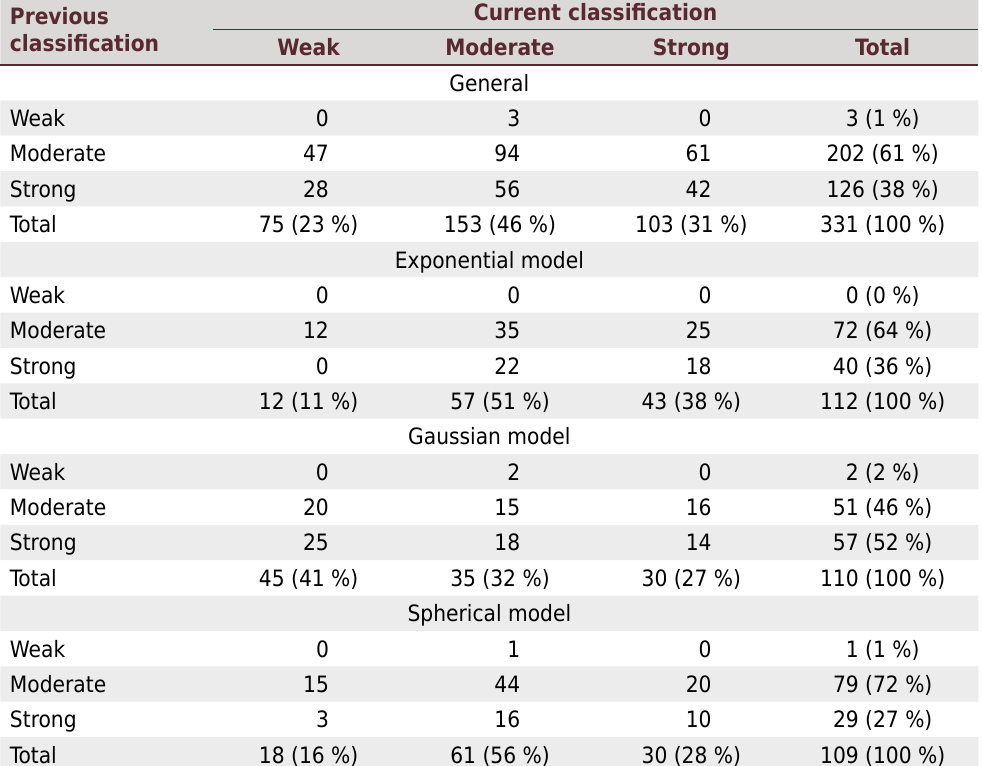
Table 1. Comparison between previous classification (Cambardella et al., 1994) and current classification of spatial dependence, proposed in this study, applied to real data, for the spherical, exponential, and Gaussian models